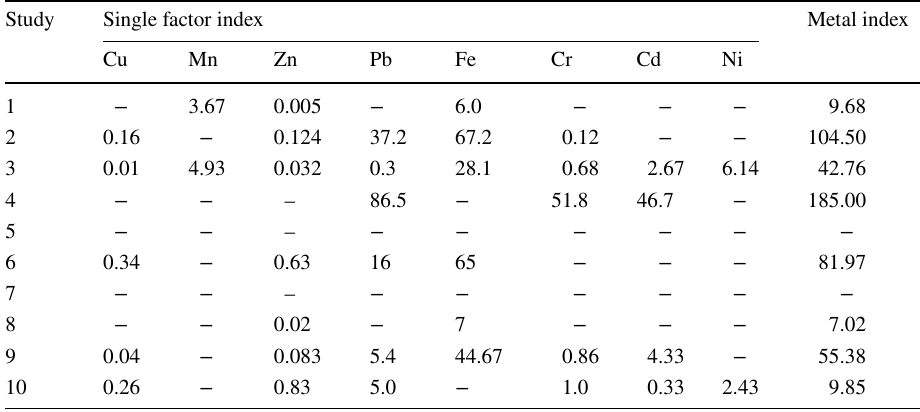
index of groundwater samples from refereed